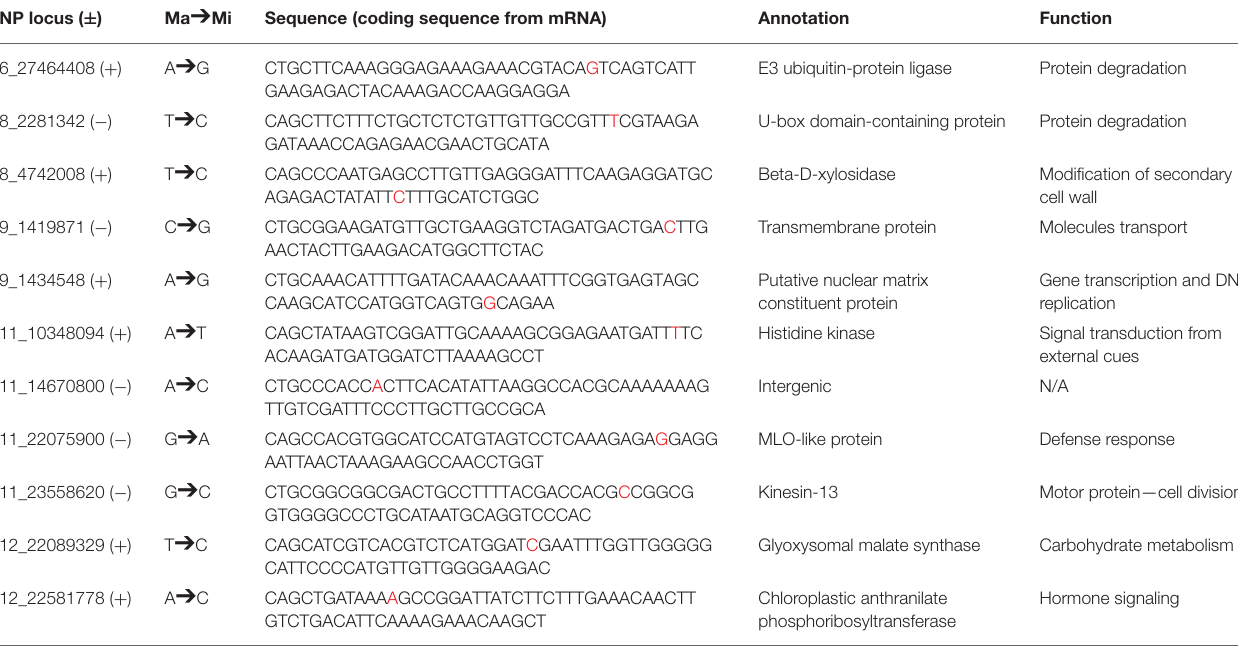
TABLE 4 | Location of SNPs on various chromosomes and annotation of corresponding genes.